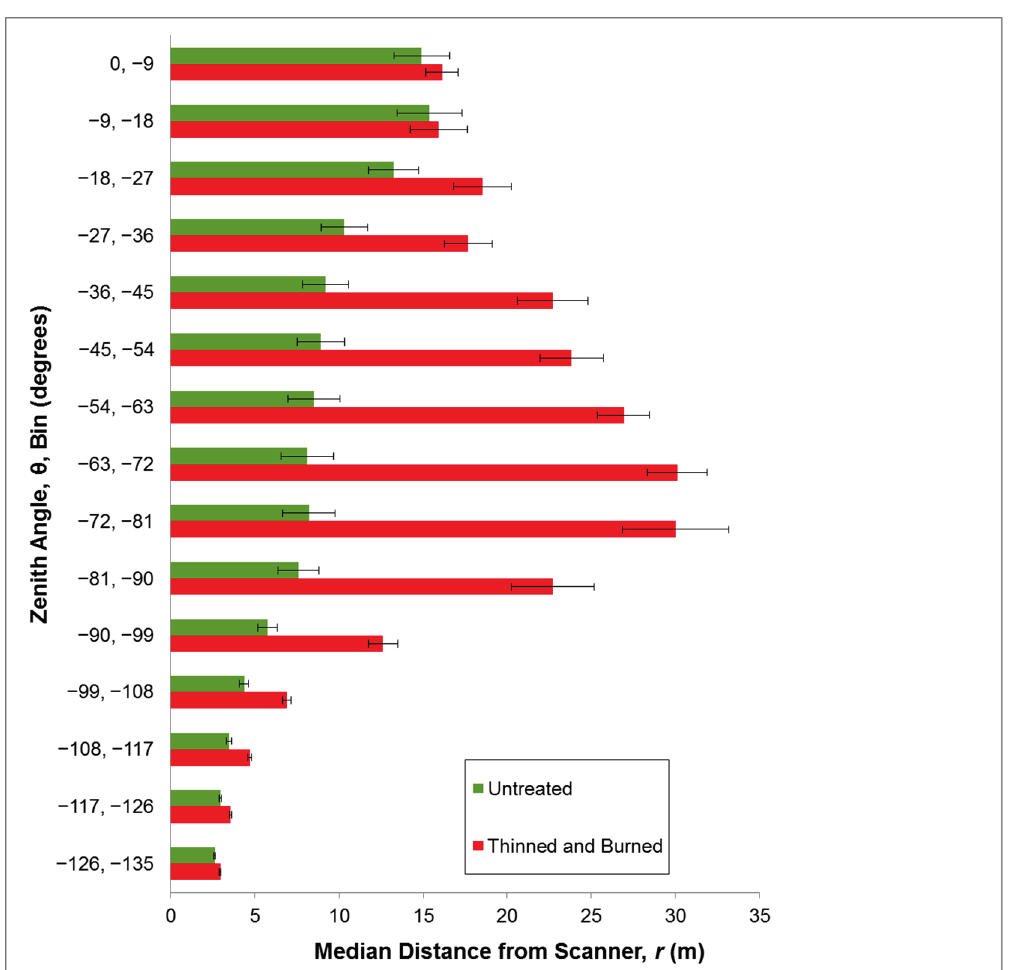
Figure 3. The Three-dimensional Vegetation Density Index (3DI) computed using 15 zenith angle bins for representative plots that were untreated and plots that were thinned and burned. Standard error bars are